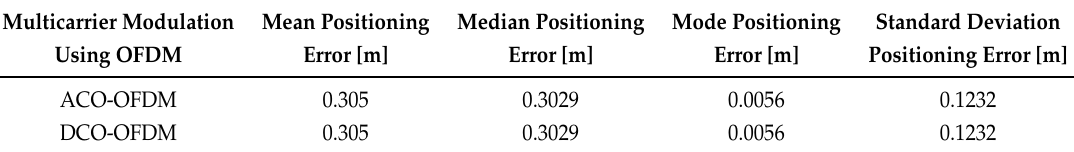
Figure 9. Illustration of Coarse Proximity-based Positioning with Frequency Division Multiplexing for DCO-OFDM and ACO-OFDM modulations under the Spatial SNR Room Distribution. Table 4. Coarse Phase Positioning Performance for Multicarrier Modulations using Orthogonal Frequency Division